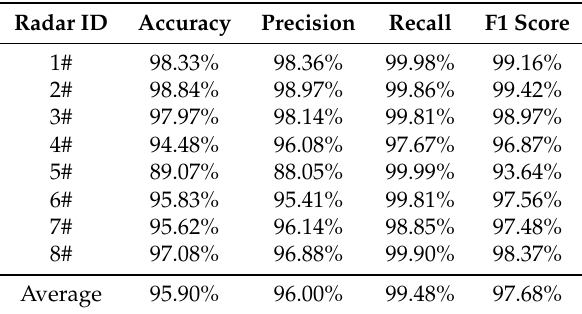
Table 5. Classification performance on testing